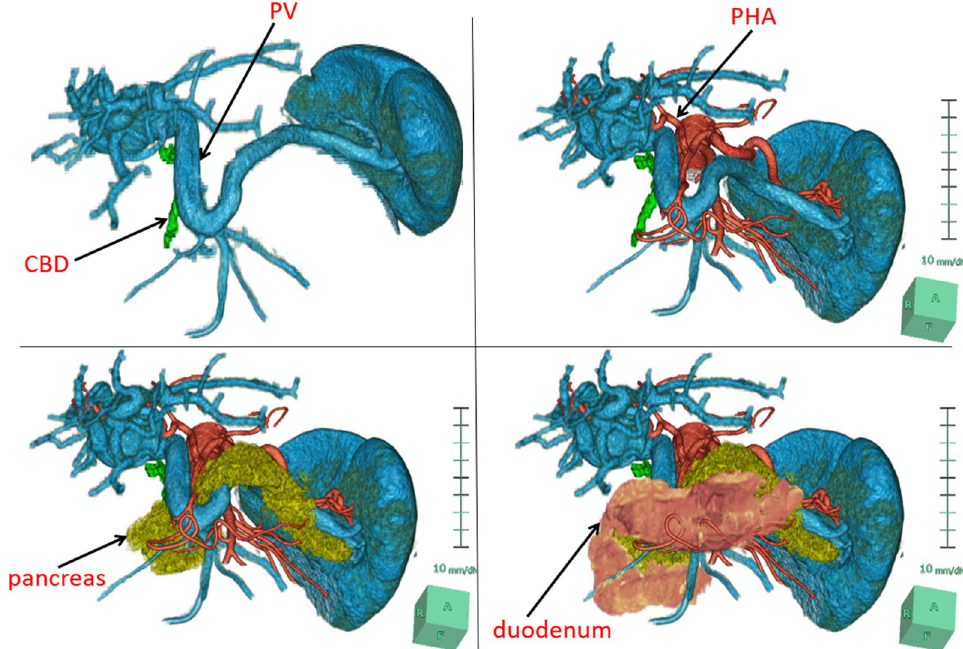
Fig. 3 Volume rendering 3D reconstruction of computed tomography. The image shows the portal vein running a prepancreatic postduodenal course, lying in front of the common bile duct, and forming an inverted L-shape, convexly caudad. CBD common bile duct, PV portal vein, PHA proper hepatic artery